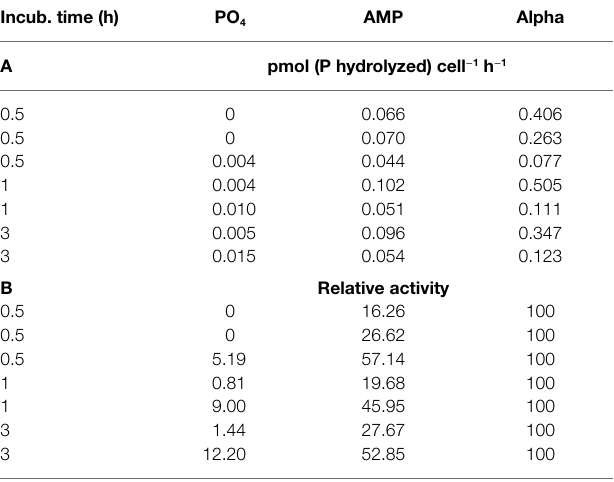
TABLE 6 | Alkaline phosphatase activity measured in exponentially growing cultures of Crocosphaera watsonii provided with either an inorganic (PO 4 ) or organic [mono phosphate adenosin (AMP) or DL- α -glycerophosphate (Alpha)] source of phosphorus for growth. Incub. time